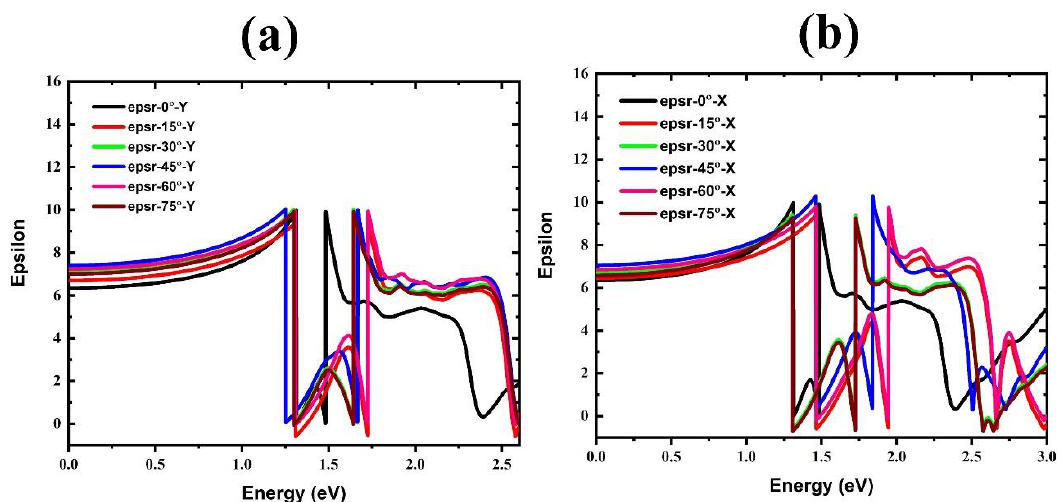
Figure 7. Real part of dielectric function of FAPbBr 3 perovskite for different FA rotations: ( a ) in Y mode and ( b ) in X mode.